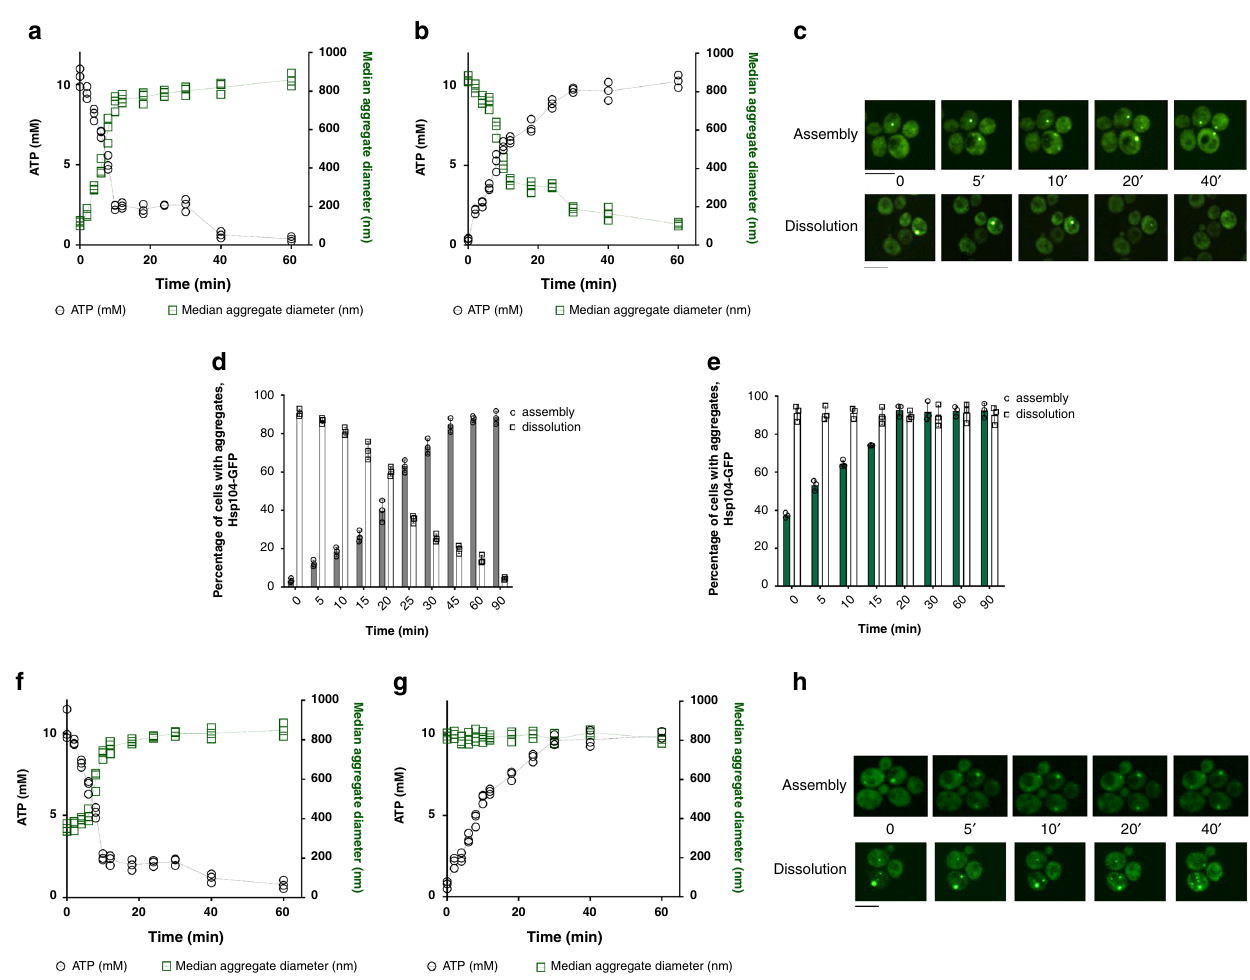
Fig. 3 Aggregate dissolution by Hsp104 determines protein aggregate steady-state size. a Cellular ATP declines during starvation (black circles), accompanied by the increase in median aggregate diameters (green squares). b During recovery period, the ATP levels are restored (black circles), and median aggregate sizes decrease with similar dynamics (green squares). In a and b , the individual data points are means of three technical replicates for each of the three biological replicates. The dashed line is connecting means of the three biological replicates at each time point. c Representative images of Hsp104-GFP foci at indicated times of assembly and dissolution. This experiment was performed in three technical replicates for each of the three biological replicates. Black bar represents 8 µ m. d The percentage of cells displaying at least one Hsp104-GFP aggregate increased during starvation in 0.02% glucose and decreased back to control level during recovery in 2% glucose. e The percentage of cells bearing at least one Hsp104 E687Q -GFP aggregate is increasing during starvation in 0.02% glucose, however, did not decrease during recovery in 2% glucose in the Hsp104 E687Q strain. In d and e , n = 1200 cells were screened for aggregates starting from three independent exponential yeast cultures for each condition. Bar height represents mean ± SD from three separate cultures, each performed in triplicate. The mean of three technical replicates for each biological replicate is displayed as single data points. f Cellular ATP declines during starvation in 0.02% glucose, followed by the increase in median aggregate diameters in the Hsp104 E687Q strain. g During recovery period, the ATP levels are restored; however, the median aggregate diameter does not decrease in the Hsp104 E687Q strain. In f and g , the displayed data points are the mean of three technical replicates for each of three biological replicates. The dashed line is connecting means of the three biological replicates at each time point. h Representative images of Hsp104 E687Q -GFP foci at indicated times of assembly and dissolution. This experiment was performed in three technical replicates for each of the three biological replicates. The black bar represents 8 µ